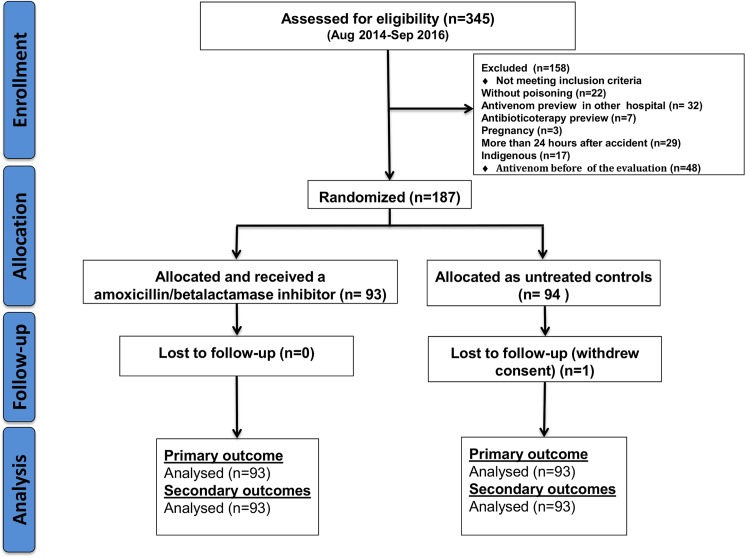
Flow chart of inclusion.Recruitment of the patients attended by snakebite at FMT-HVD, allocation and follow-up in the clinical trial.